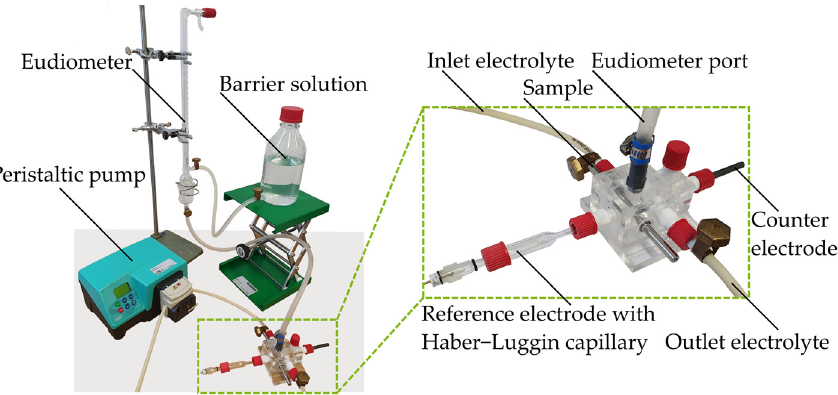
Figure 5. General experimental setup for the corrosion investigation. The temperature control unit is not shown for reasons of clarity. Table 1. Data for the design of immersion tests with galvanostatic polarization on WE43 and WE43 PEO in 0.9% NaCl solution at 36.5 °C.